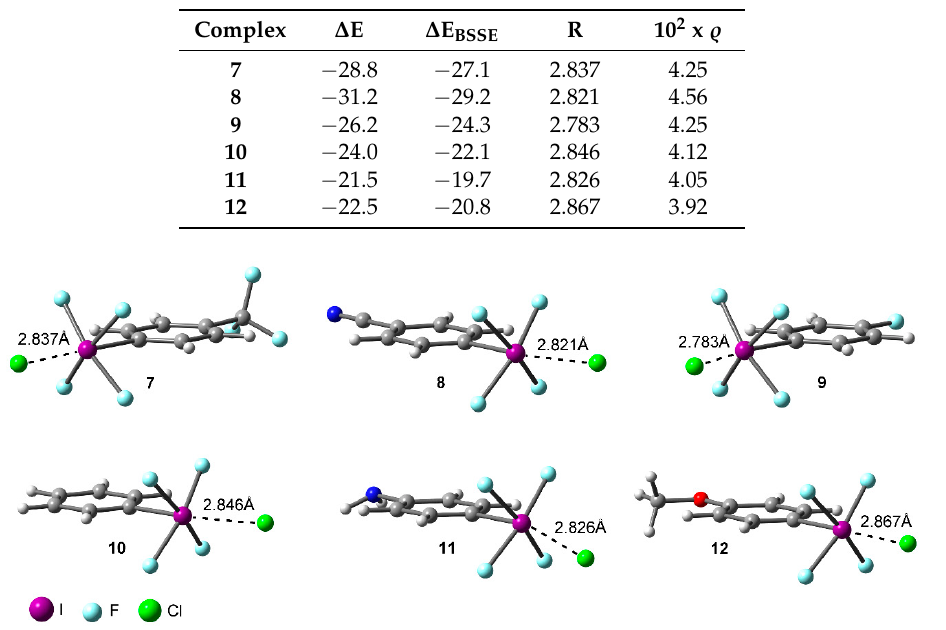
Table 1. Interaction energies without and with BSSE correction ( Δ E and Δ E BSSE respectively, kcal/mol), equilibrium distances (R, Å), and value of the density at the bond CP (10 2 x ρ , a.u.) for Complexes 7 – 12 at the RI-MP2/def2-TZVPD level of theory.